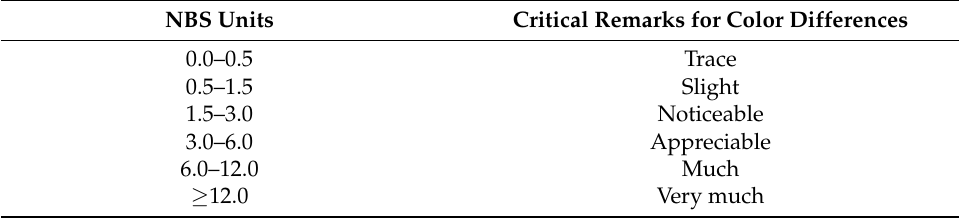
Table 2. National Bureau of Standards system of expressing color difference (NBS).